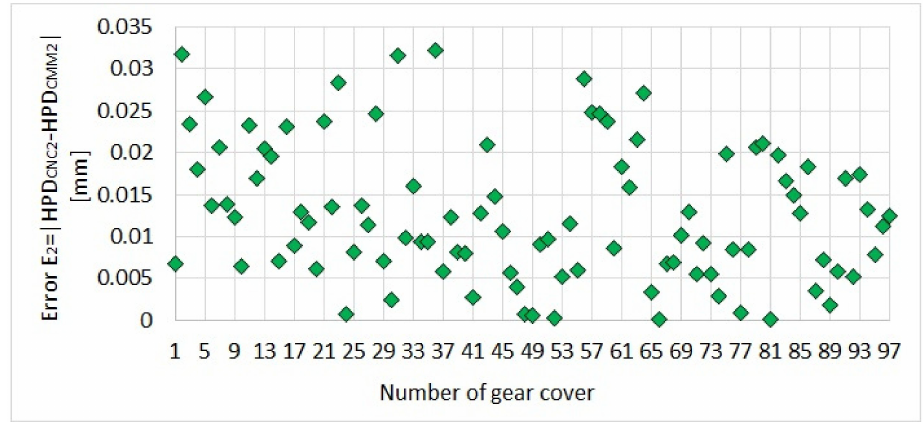
Figure 8. Error E 2 as an absolute value of the difference of deviations resulting from CMM and CNC measurements for bearing seat